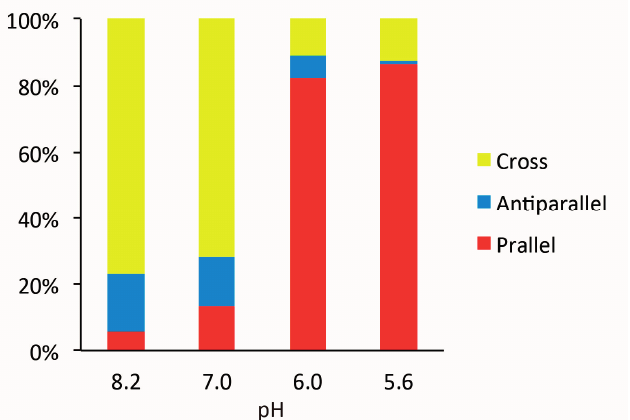
Figure 3. Distribution of three forms of DNA Origami Pliers in AFM images at various